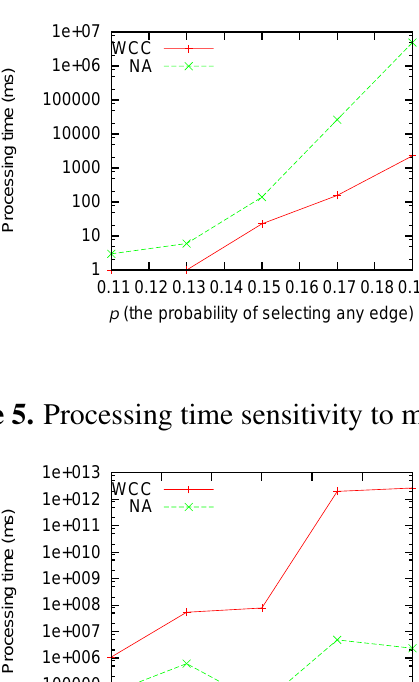
Figure 4. Processing time sensitivity to p .